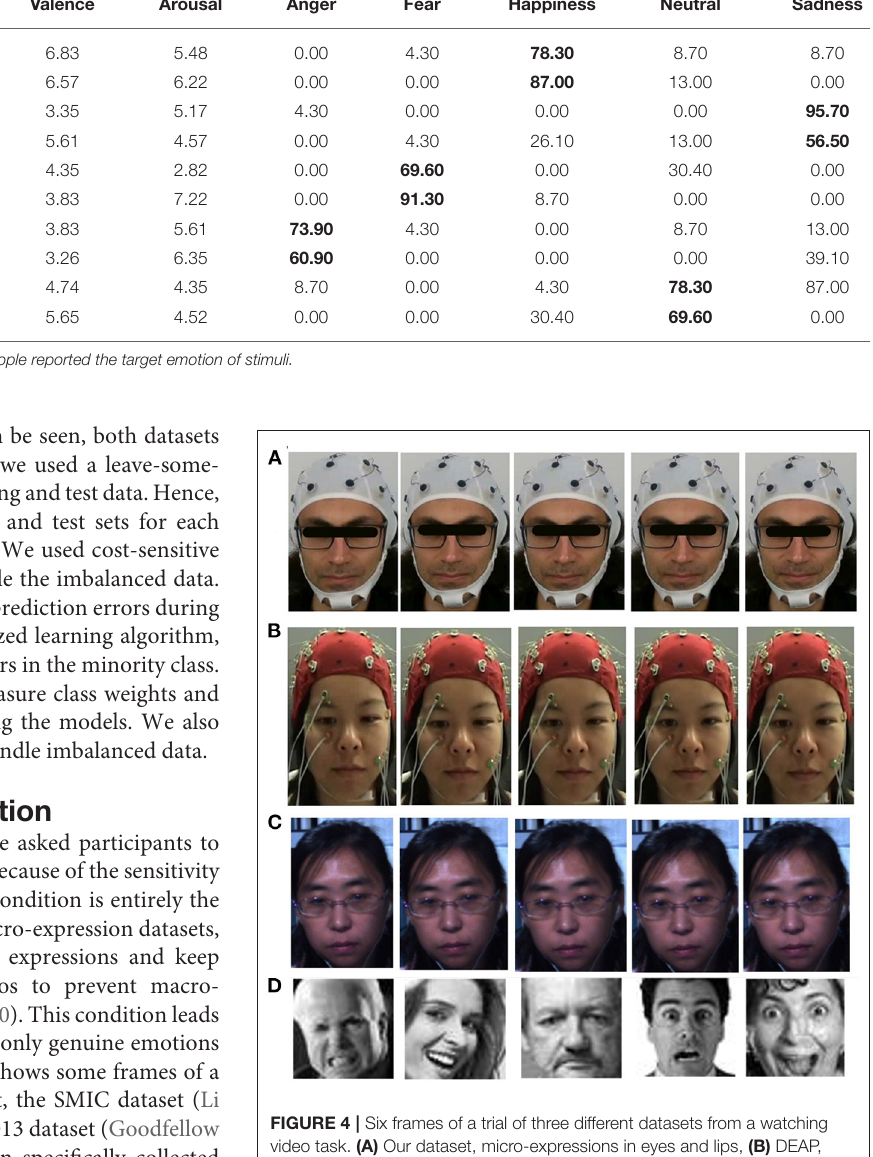
TABLE 3 | The Mean arousal and valence rating values and the percentage of participants who reported each emotion for each video-clip in our dataset. Target emotion Valence Arousal Anger Fear Happiness Neutral Sadness